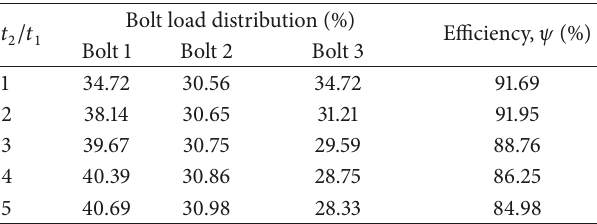
Table 8: Bolt load distribution for variation in plate thickness ratio ( 𝑡 2 /𝑡 1